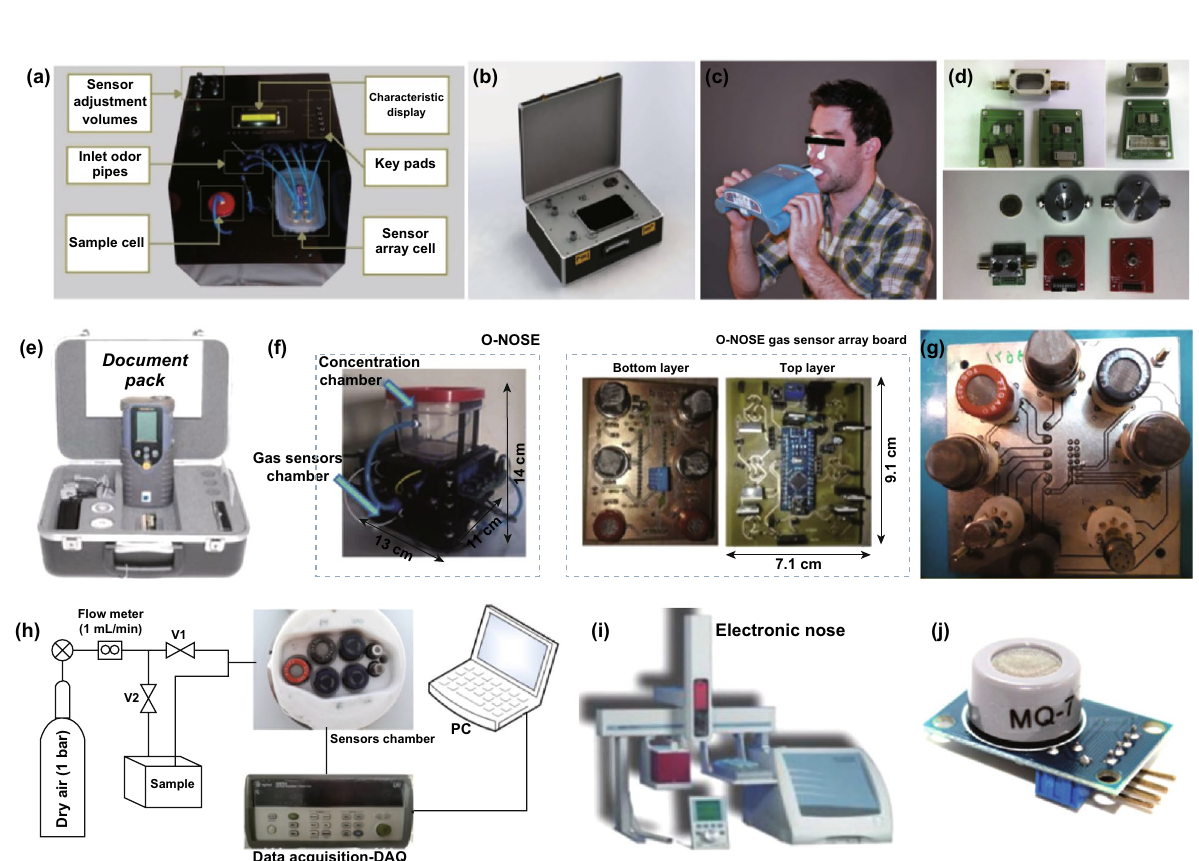
Fig. 21 Schematic of the diffferent commercial e-nose. a Photographic image of Hanwei e-nose. Reproduced with permission [212]. Copyright 2017, Springer. b E-nose system “NOS.E” produced by Figaro Engineering Inc. [168]. Copyright 2018, IEEE. c Aeonose to diagnosis pros- tate cancer. Reproduced with permission [170]. Copyright 2018, European Association of Urology. d E-nose produced by institute of Physics Technology and Information, Spanish Council for Scientific Research. Reproduce with permission [213]. Copyright 2018, Elsevier Ltd. e The picture of Cyranose 320. Reproduce with permission [214]. From Chang and Heinemann, Copyright 2018, ASABE. f The sensors manufactured by Hanwei Sensors. Reproduced with permission [215]. Copyright 2019, Elsevier Ltd. g E-nose produced by Figaro Engineering, Inc., Hanwei company and FIS Inc. Reproduced with permission [216]. Copyright 2018, Elsevier Ltd. h E-nose based on MOS TGS and FIS sensors. Repro- duced with permission [217]. Copyright 2018, sensors. I Fox 3000 electronic nose system. Reproduced with permission [218]. Copyright